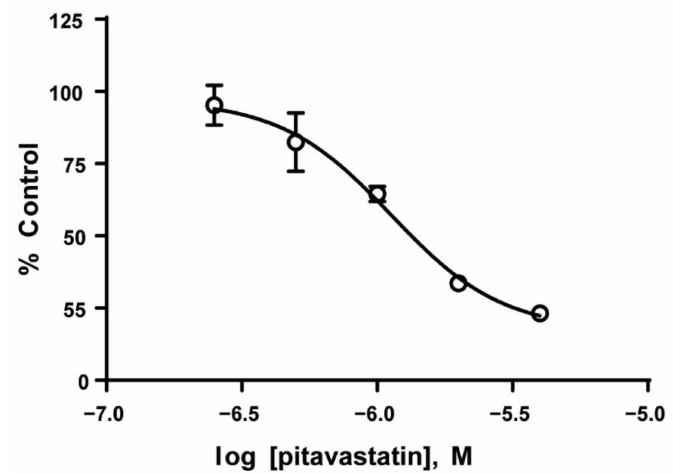
Figure 4. Inhibition of lipid synthesis decreases ALL cell proliferation. REH cell lines were treated with the indicated concentrations of pitavastatin, and the cell proliferation was measured as described in the methods. The data are represented as mean ± SD of a study performed in triplicate at least three independent times.